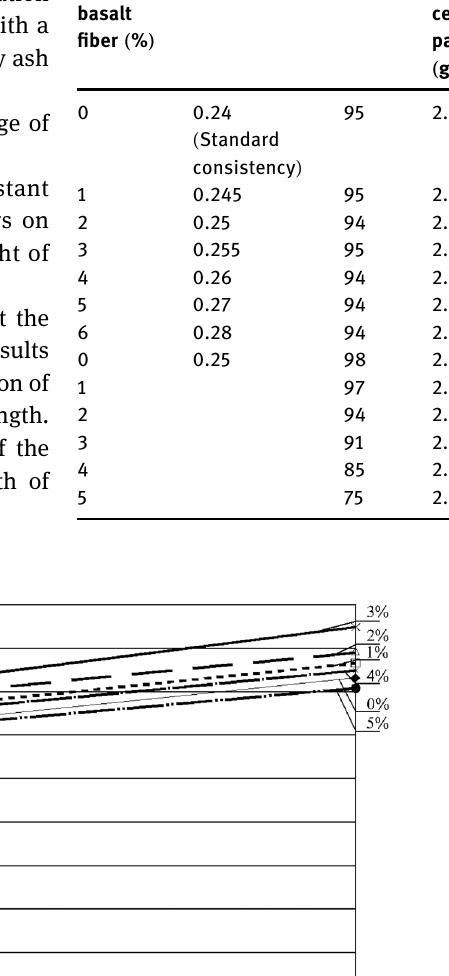
Table 8: In fl uence of fl y ash fi bers on the workability of cement paste and the density of cement stone Content